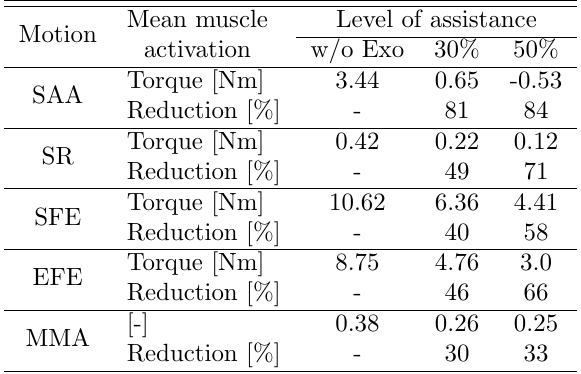
Table 2: Mean muscle activation expressed with equiv- alent joint torques and maximum muscle ac-